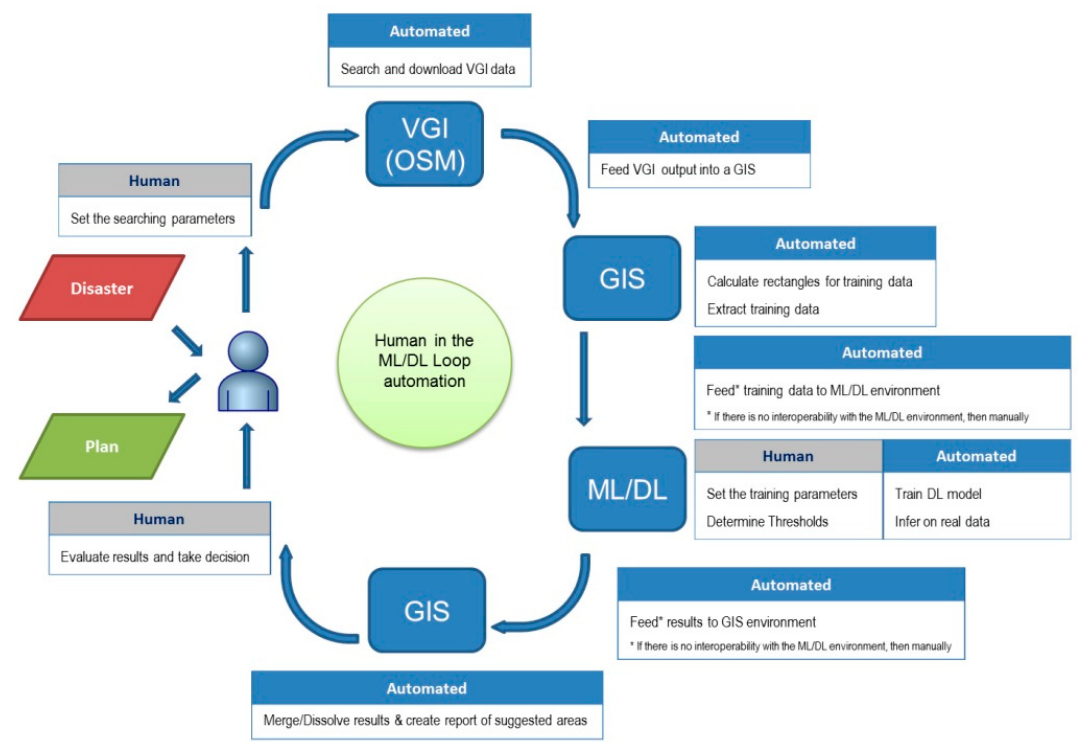
Figure 8. End-to-end ML / DL methodology for object identification.